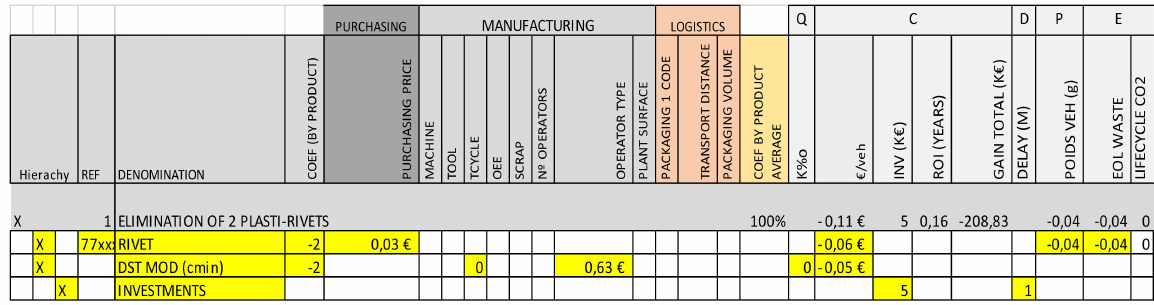
Figure 7. “Modeling Matrix” with detailed impacts calculation (partially